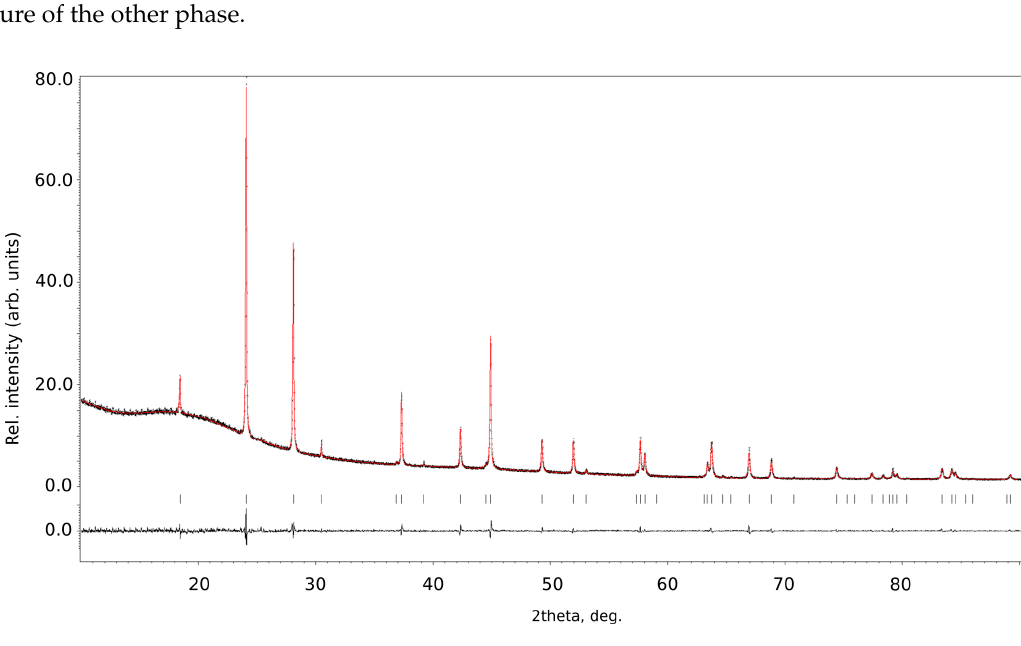
Figure 9. Powder X-ray diffraction pattern (at 293 K) of BaOsF 6 : the experimental data (black crosses), the Le Bail profile (red), and the differential profile (bottom, black). The calculated reflection positions for BaOsF 6 are shown as black ticks. R p = 0.0189, wR p = 0.0264.